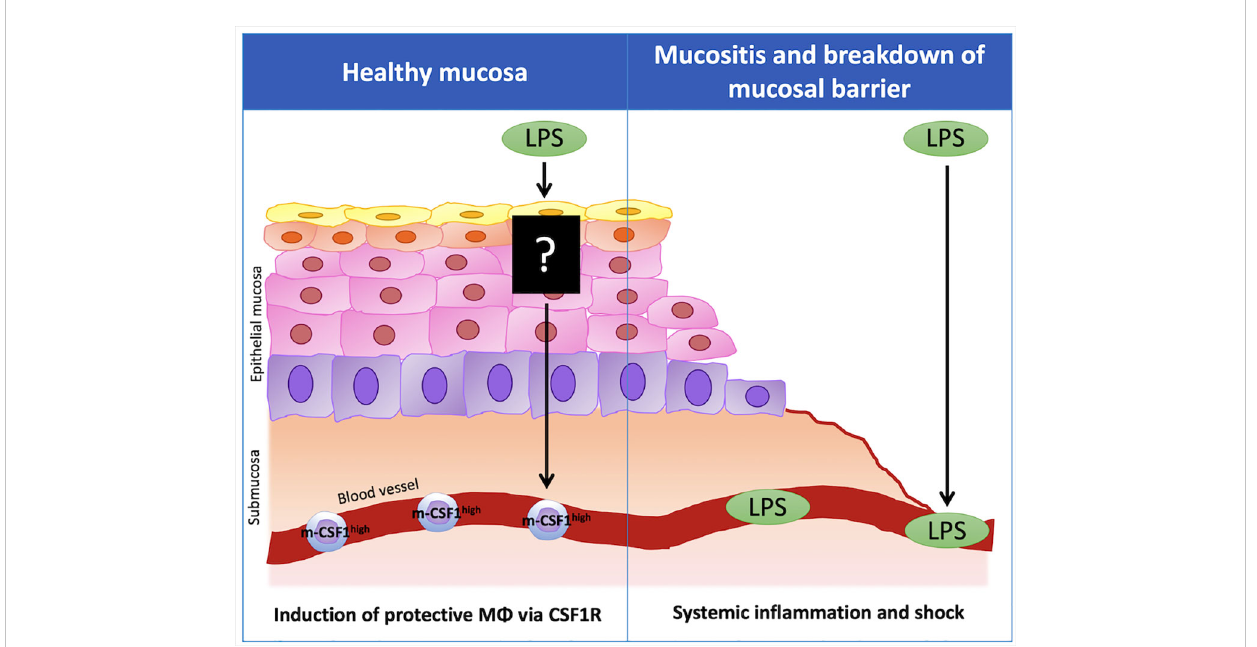
FIGURE 3 The importance of healthy mucosa for disease-preventing effect of OAL. In healthy mucosa, LPS taken by the oral route does not enter the blood, but acts on the immune system in the oral or upper gastrointestinal mucosa and induces the expression of m-CSF1 in peripheral leukocytes. The leukocytes that highly express m-CSF1 (m-CSF1 high leukocytes) patrol the choroid plexus and maintain brain homeostasis. Upon sensing pathological conditions, m-CSF1 high leukocytes activate microglial CSF1R signaling in the choroid plexus, inducing transformation to neuroprotective microglia to prevent neuropathy. On the other hand, when the mucosal barrier is disrupted due to mucositis, LPS may be absorbed into the blood and induce in fl ammation and shock when it circulates systemically. m-CSF1, membranous colony stimulating factor 1; CSF1R, CSF1